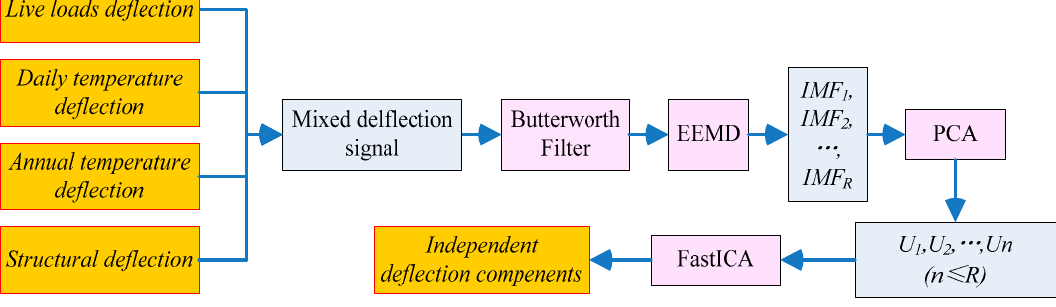
Figure 1. Flowchart of the proposed algorithm.